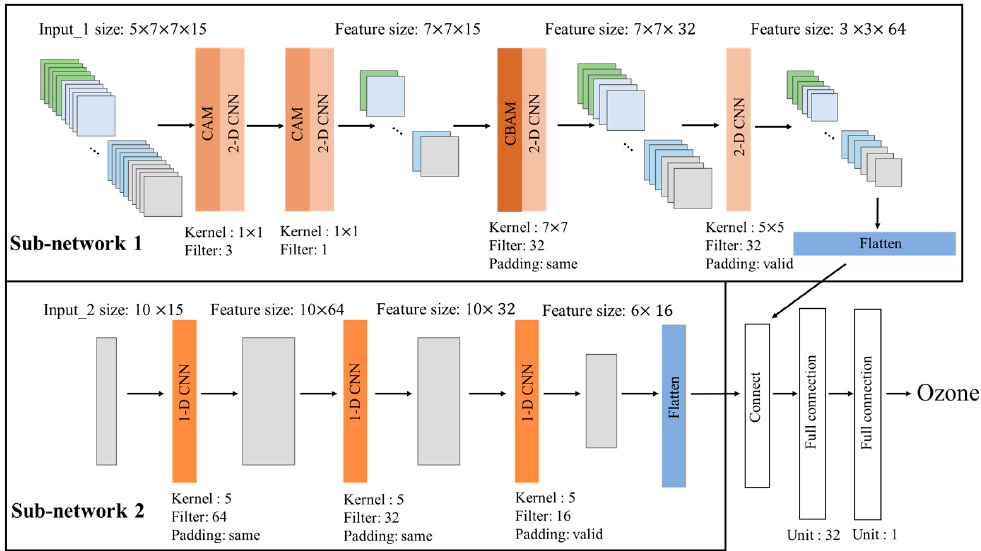
Figure 2. Model architecture.